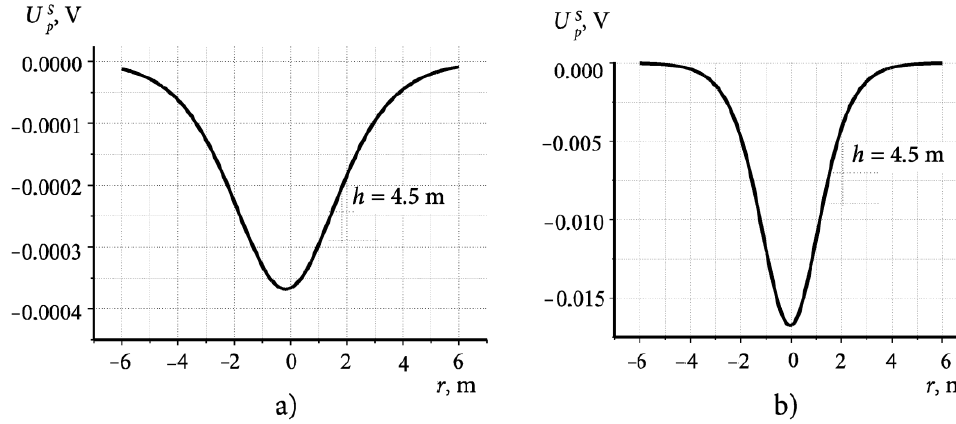
Figure 5. The flow characteristic:( a )—corresponds to the free space for H = ∞ , h =3 m; ( b )—the flow characteristic for H =6 m, h = 3 m.